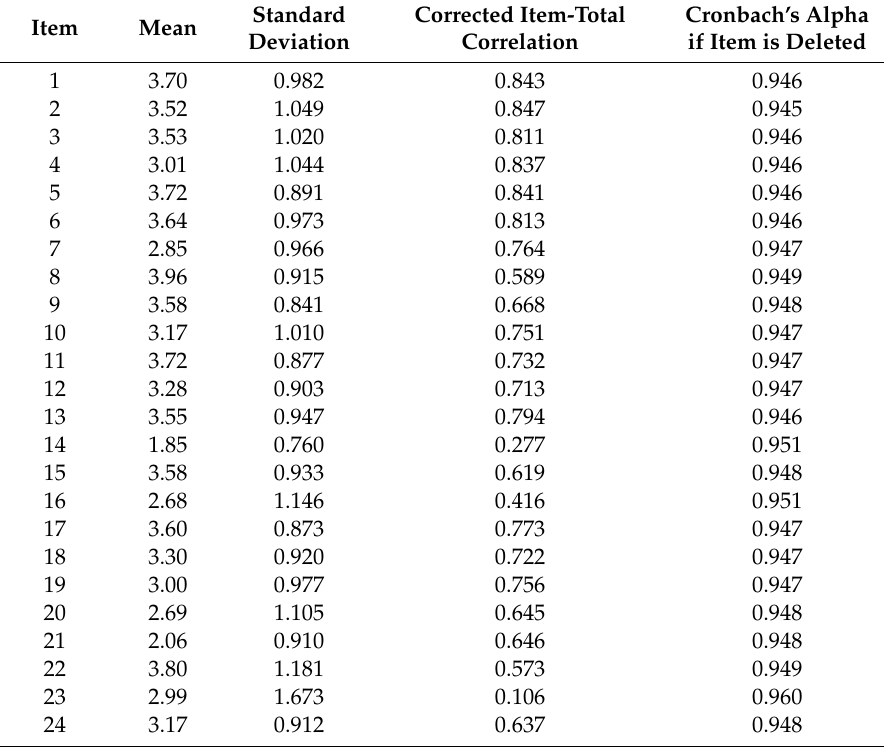
Table 1. Descriptive statistics and internal consistency for the items.